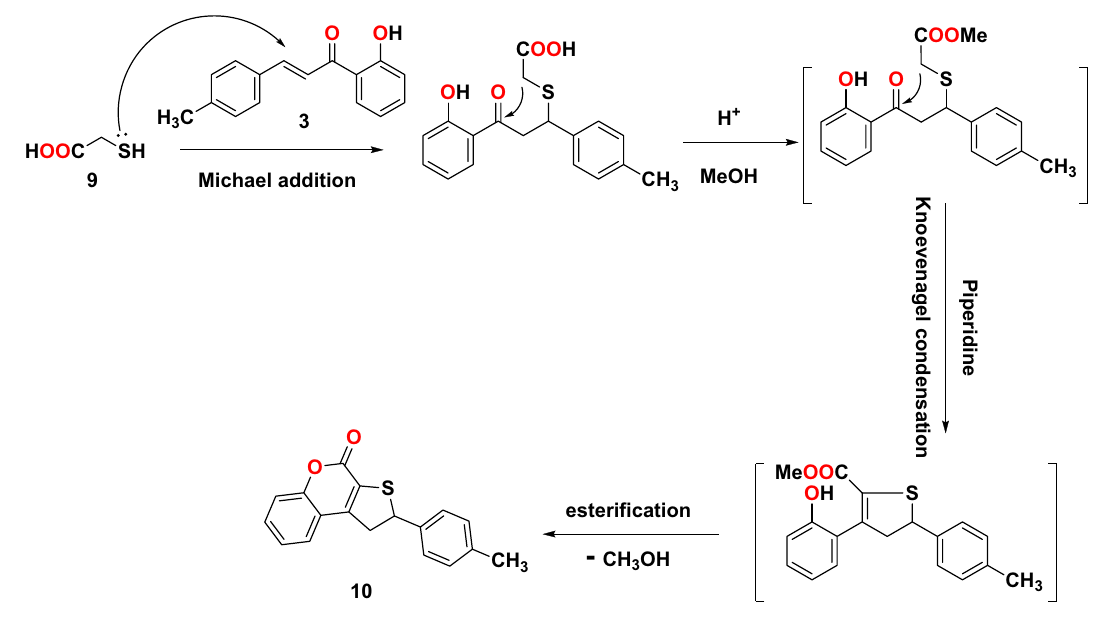
Figure 5. A possible mechanism for the formation of compound 10